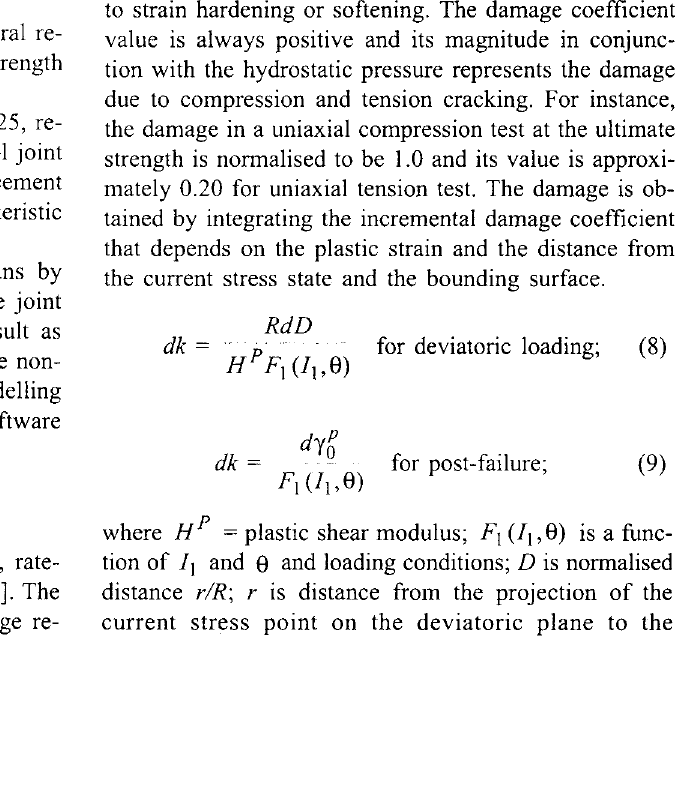
Fig 4. Bounding surface The bounding surface function is: